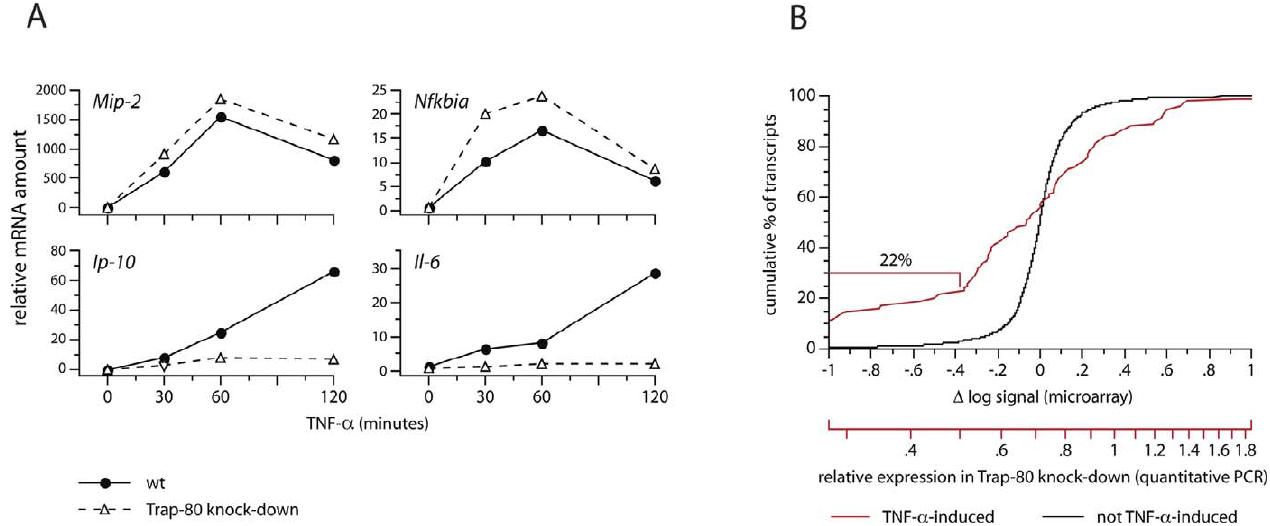
Figure 2. Trap-80–Dependent and –Independent Genes (A) Expression of Mip-2 , Nfkbia , Ip-10 , and Il-6 mRNA in subconfluent cultures of wild-type and Trap-80 knock-down fibroblasts, after stimulation with TNF- a . mRNA levels are expressed relative to unstimulated, wild-type cells; the results presented here are representative of more than ten experiments. (B) Trap-80–dependence of TNF- a –induced versus noninduced genes. Cumulative percentage of transcripts whose expression in Trap-80 knock-down cells exceeds the indicated level in wild-type cells, expressed both as the D log signal of the microarray probes (upper scale) and the calculated relative expression level using a standard curve generated by quantitative PCR of a subset of 36 genes (lower scale). The red line represents the top 100 TNF- a – induced transcripts; the black line represents 5,000 transcripts whose levels were unchanged by TNF- a stimulation. Table S1 lists the top 50 Trap-80– dependent and –independent TNF- a –induced genes.